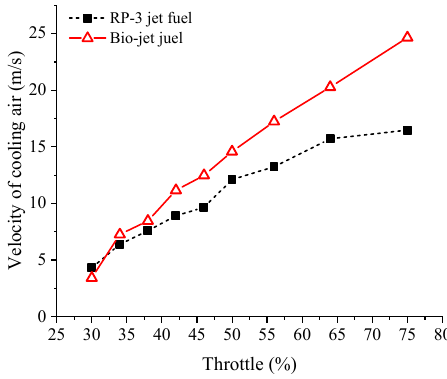
Figure 10. Variation of cooling air velocity against throttle